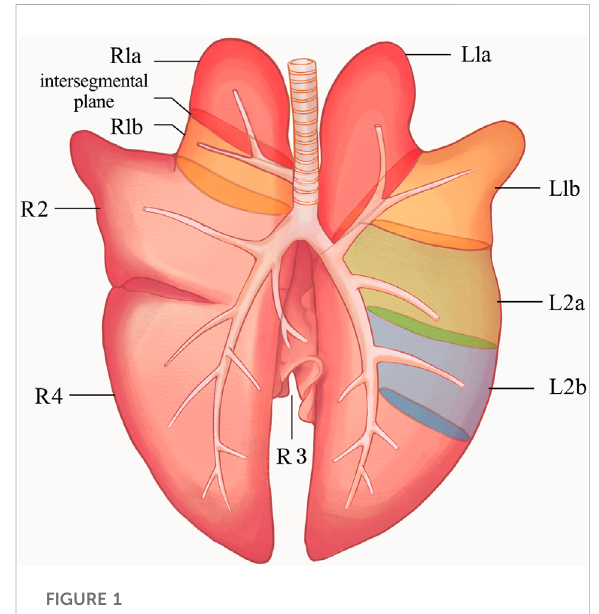
FIGURE 1 Anatomical diagram of porcine lung. L1, left cranial lobe; L2, left caudal lobe; R1, right cranial lobe; R2, right middle lobe; R3, right accessory lobe; R4, right caudal lobe. The ventilation of each lung segment is controlled by its corresponding bronchus. The bronchus of R1 opens directly to the main trachea. The R1a, R1b, L1a, L1b, L2a, and L2b segments were used in the pre- experiments, and fi nally R1a was selected for the segmentectomy, the intersegmental plane was the location of the sealant application in the experiments. R1a, R1b (a and b segments of the right cranial lobe); L1a, L1b (a and b segments of the left cranial lobe); L2a, L2b (a and b segments of the left caudal